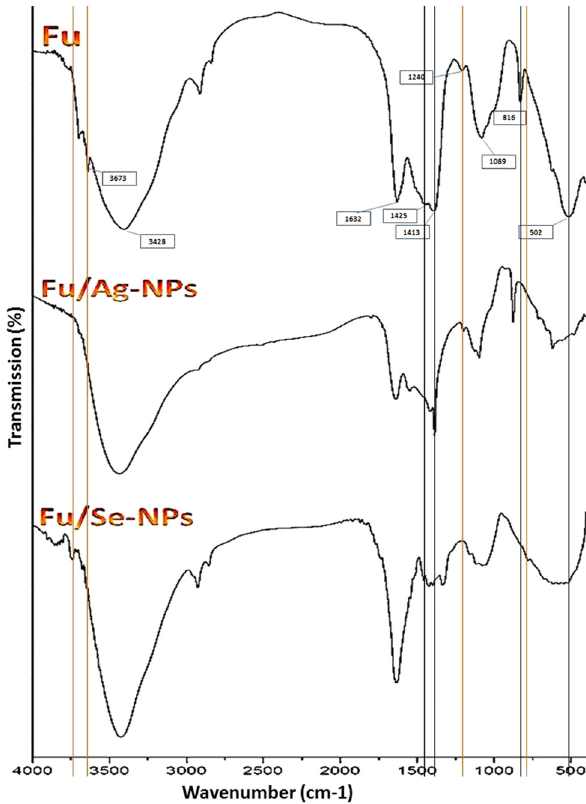
Figure 2: FTIR spectra of extracted Fu and polymer - decorated NPs of silver ( Fu/Ag - NPs ) and selenium ( Fu/Se - NPs ) . The main in fl uencing bands in Ag - NPs and Se - NPs synthesis are indicated by black and orange lines,